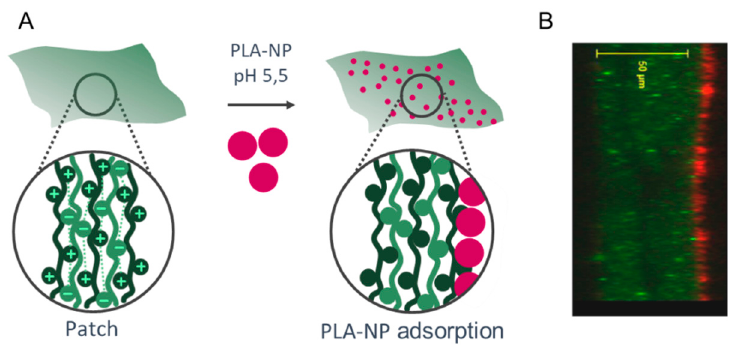
Figure 1. Mucosal NP delivery by a mucoadhesive LbL patch. ( A ) (CHI/HyA) 100 patch and PLA-NP adsorption on the surface. ( B ) Optical section of the PLA-NP (bodipyTR, red) adsorbed on the mucoadhesive LbL patch (CHI FITC , green).